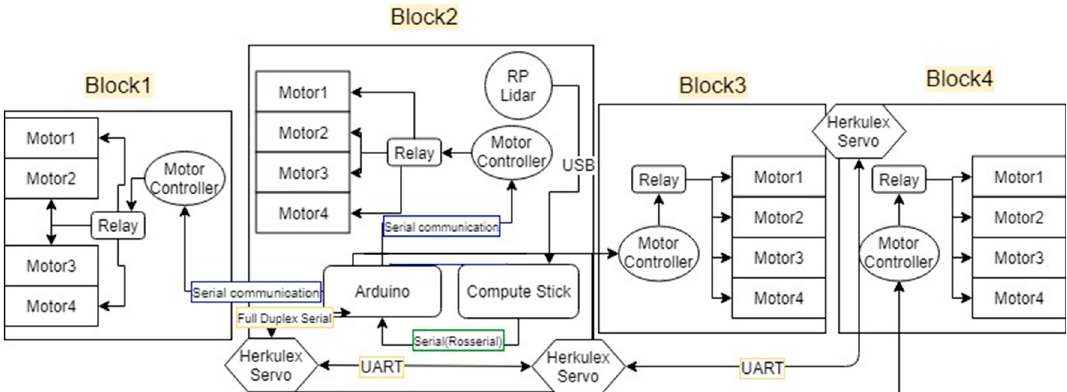
Figure 2. hTetro Hardware Architecture.